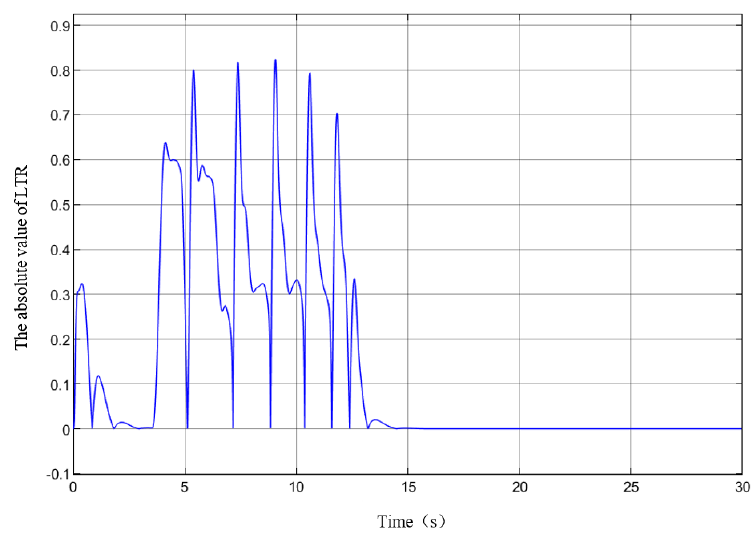
Figure 10. Absolute value change curve of LTR for double lane-change test.